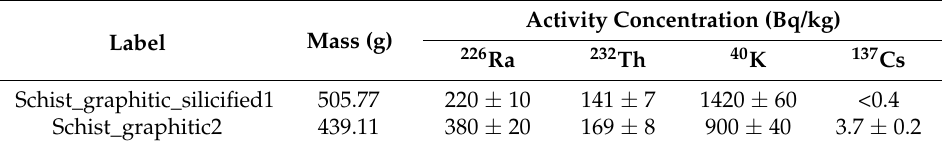
Table 5. Radioactivity of characteristic samples from the Inovska Reka occurrence.